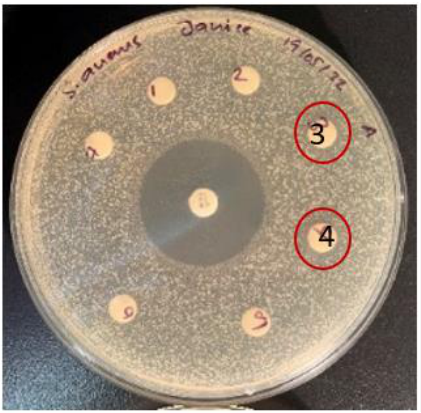
Figure 6. Tuckeroo plum flesh (3) and seeds (4) antibacterial activity plates.